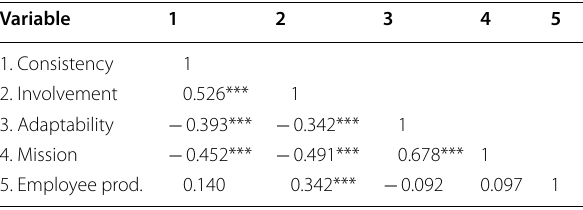
Table 6 Correlation analysis summary